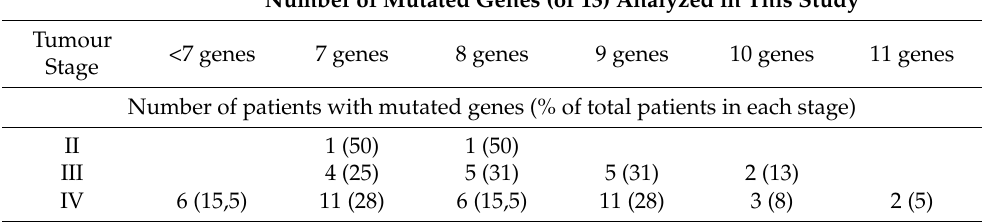
Table 3. Genetic heterogeneity of mCRC tumours investigated in this study according to tumour stage. Patient and number of mutated genes according to tumour stage are